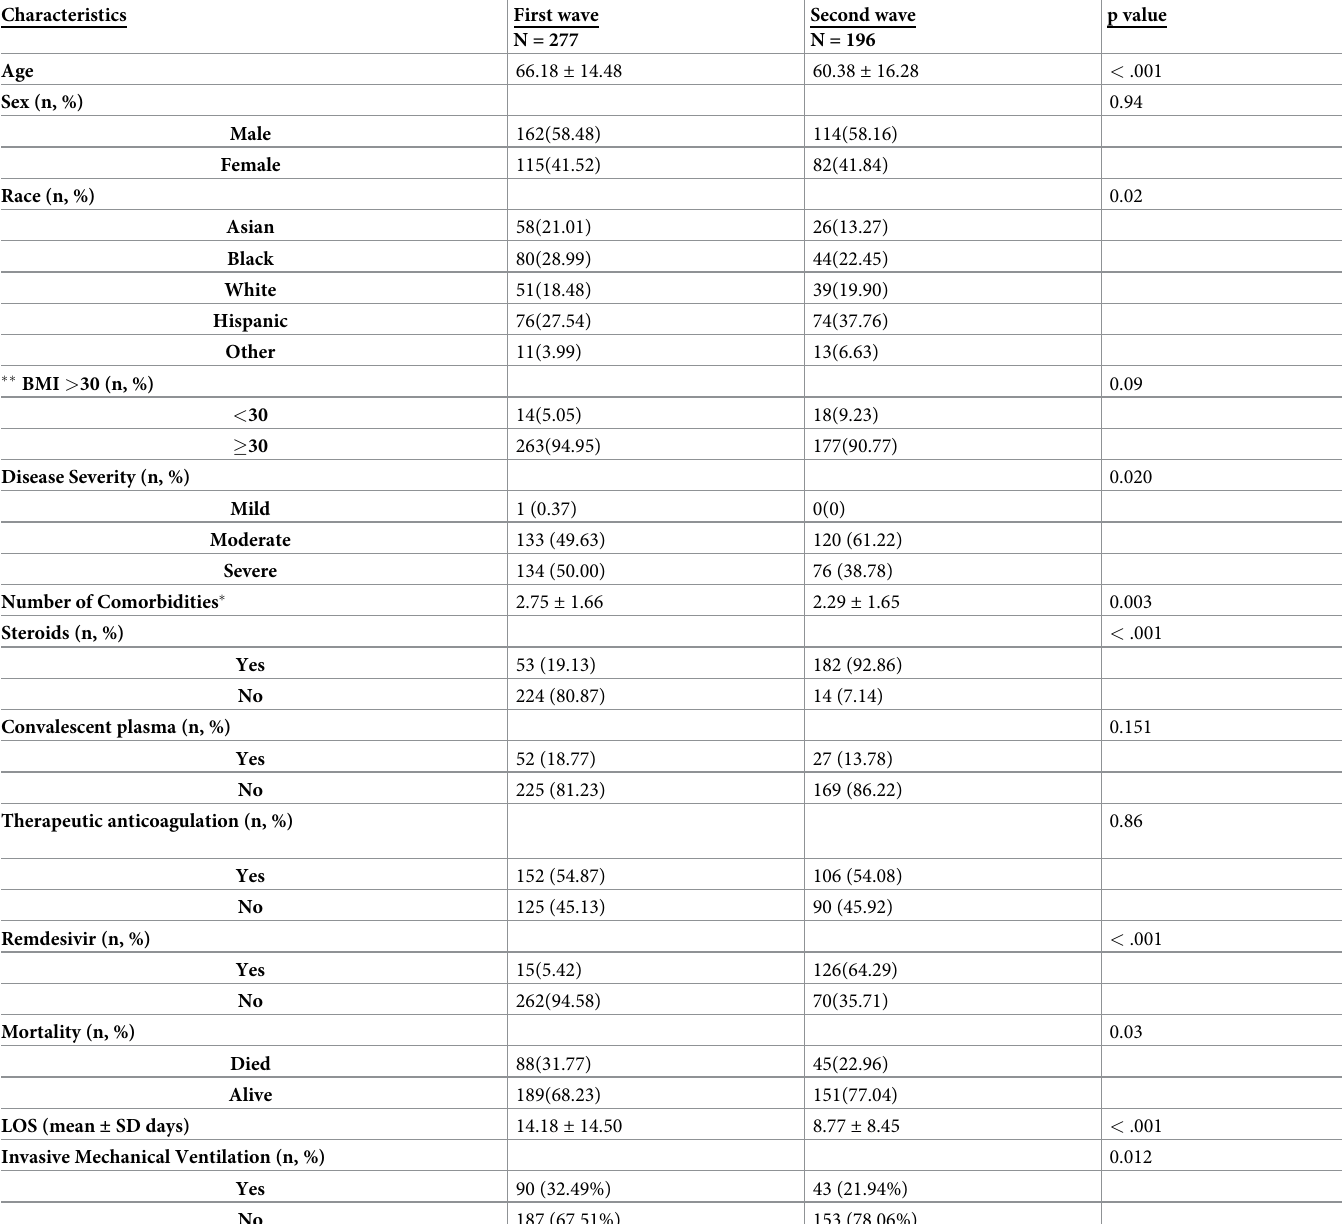
Table 1. Baseline characteristics of